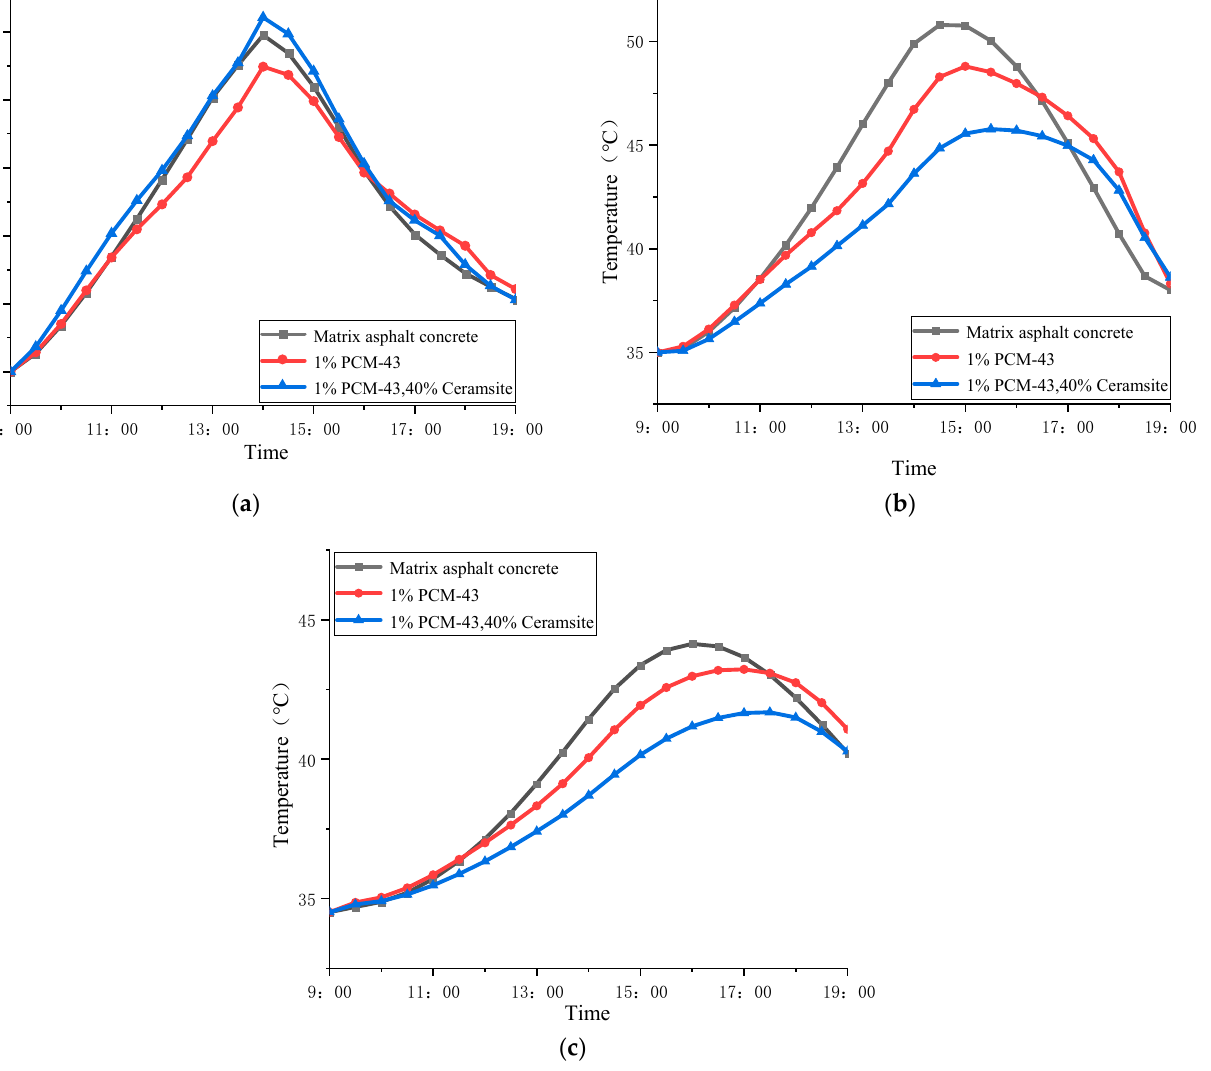
Figure 9. The temperature of pavement structure changing with time: ( a ) top of the upper layer; ( b ) top of the middle layer; ( c ) top of the lower layer.